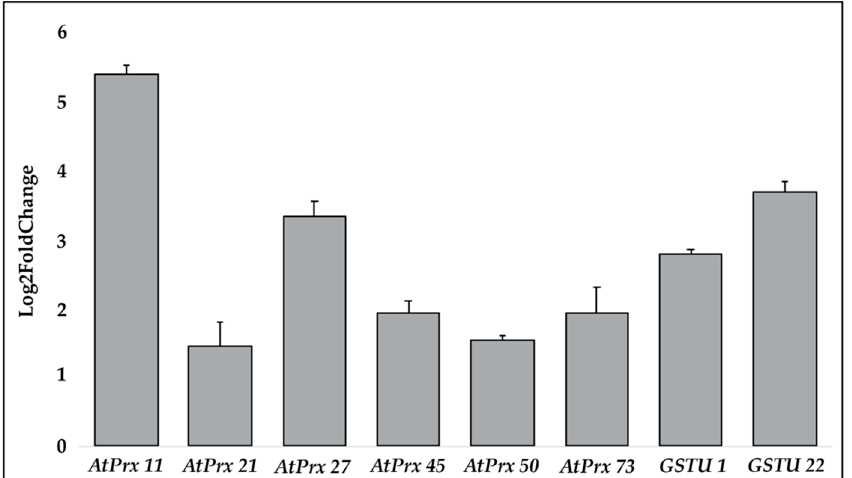
Figure 6. qPCR of class III peroxidase and glutathione S-transferase genes under salinity stress with and without Cu-chl treatment. Log2FoldChange (treated vs not treated) ≥ 1.0 was considered as significant upregulation, and all of them showed similar level of differential expression as RNA-Seq data. Log2FoldChange ± SE shown here are from three technical replicates of a biological sample.